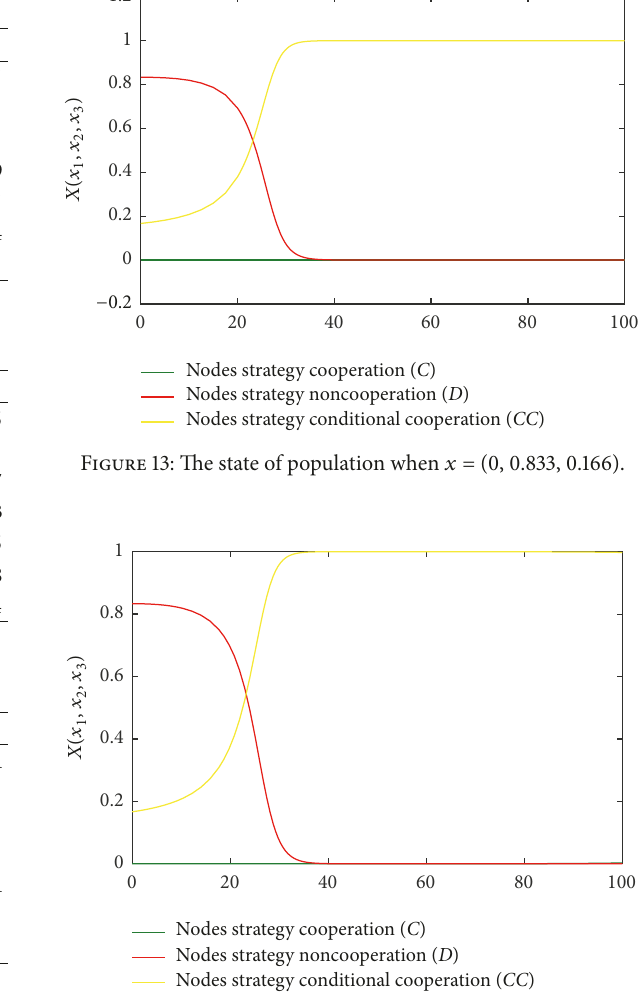
Figure 14: The state of population when 𝑥 = (0.0001, 0.833,